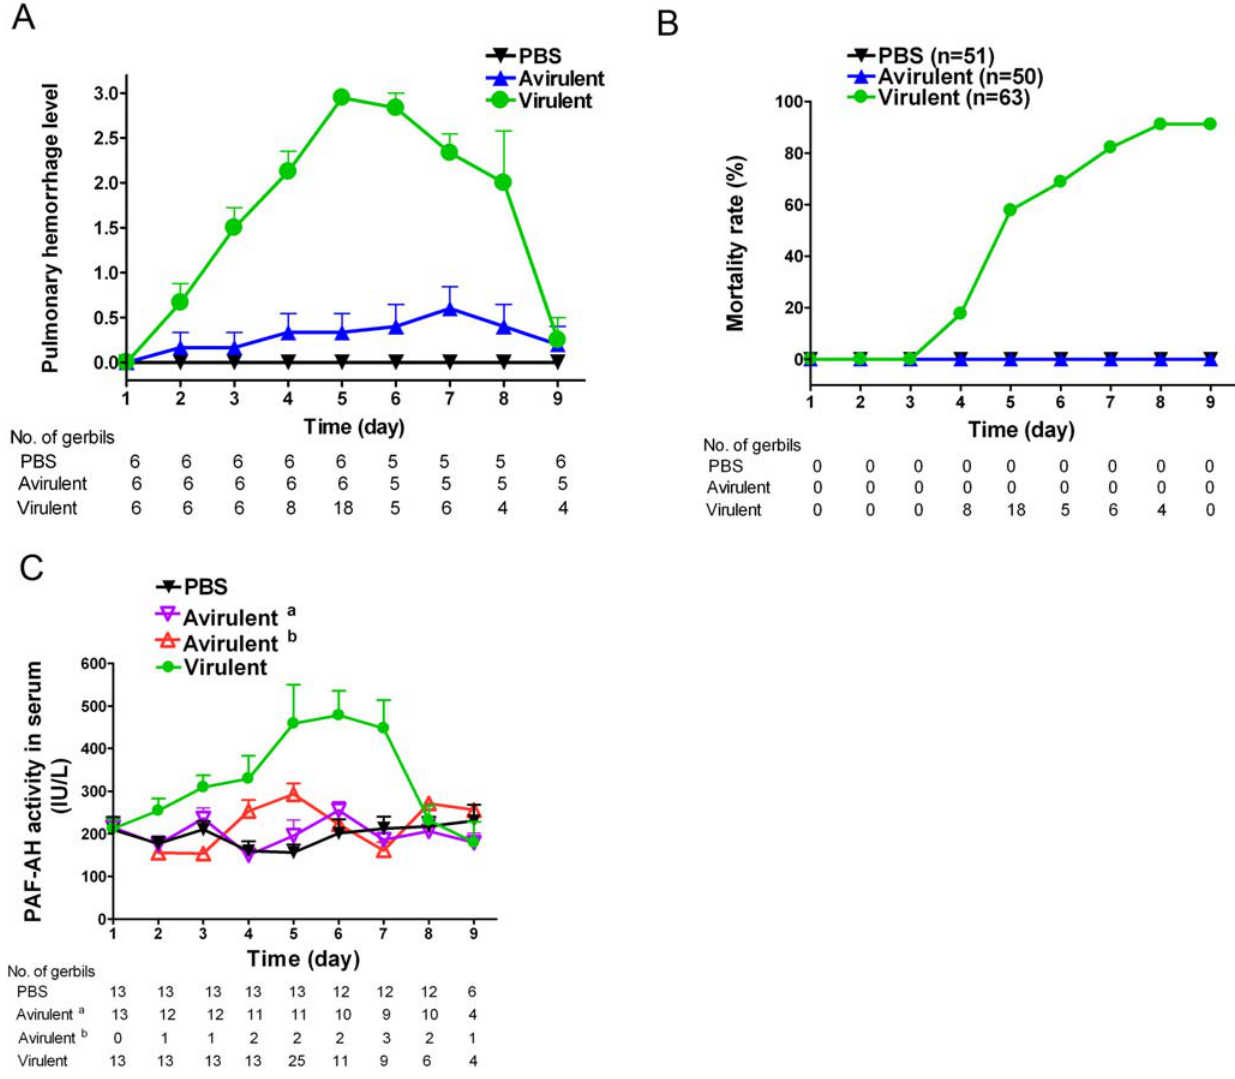
Figure 4. Time course of pulmonary hemorrhage (A), mortality rate (B) and PAF-AH level in serum (C) of gerbils inoculated with PBS, the avirulent strain of L.interrogans serovar Lai and L.interrogans serovar Lai. PBS, injected with PBS alone; avirulent, injected with the avirulent strain of L. interrogans serovar Lai; virulent, injected with L. interrogans serovar Lai. (A) The measurement and plot of pulmonary hemorrhage referred to Materials and Methods . (C) Avirulent a , no pulmonary hemorrhage observed in the gerbils injected with the avirulent strain of L. interrogans serovar Lai; avirulent b , pulmonary hemorrhage observed in the gerbils injected with the avirulent strain of L. interrogans serovar Lai. At indicated time, number of animals was shown under the figures. Bar indicated the standard